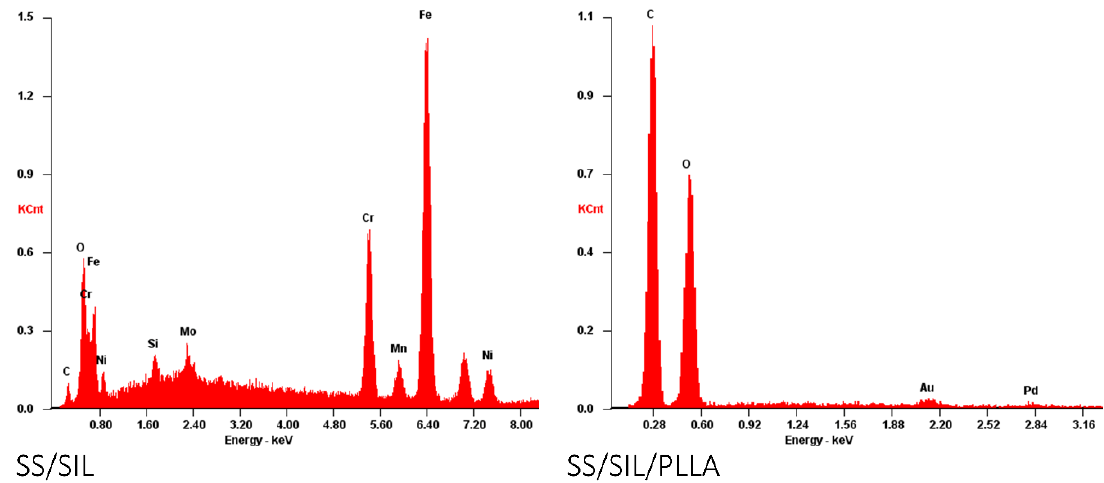
Figure 6. EDS analysis. Left panel: SS/SIL (unseeded sample) and right panel: SS/SIL/PLLA group (unseeded sample).